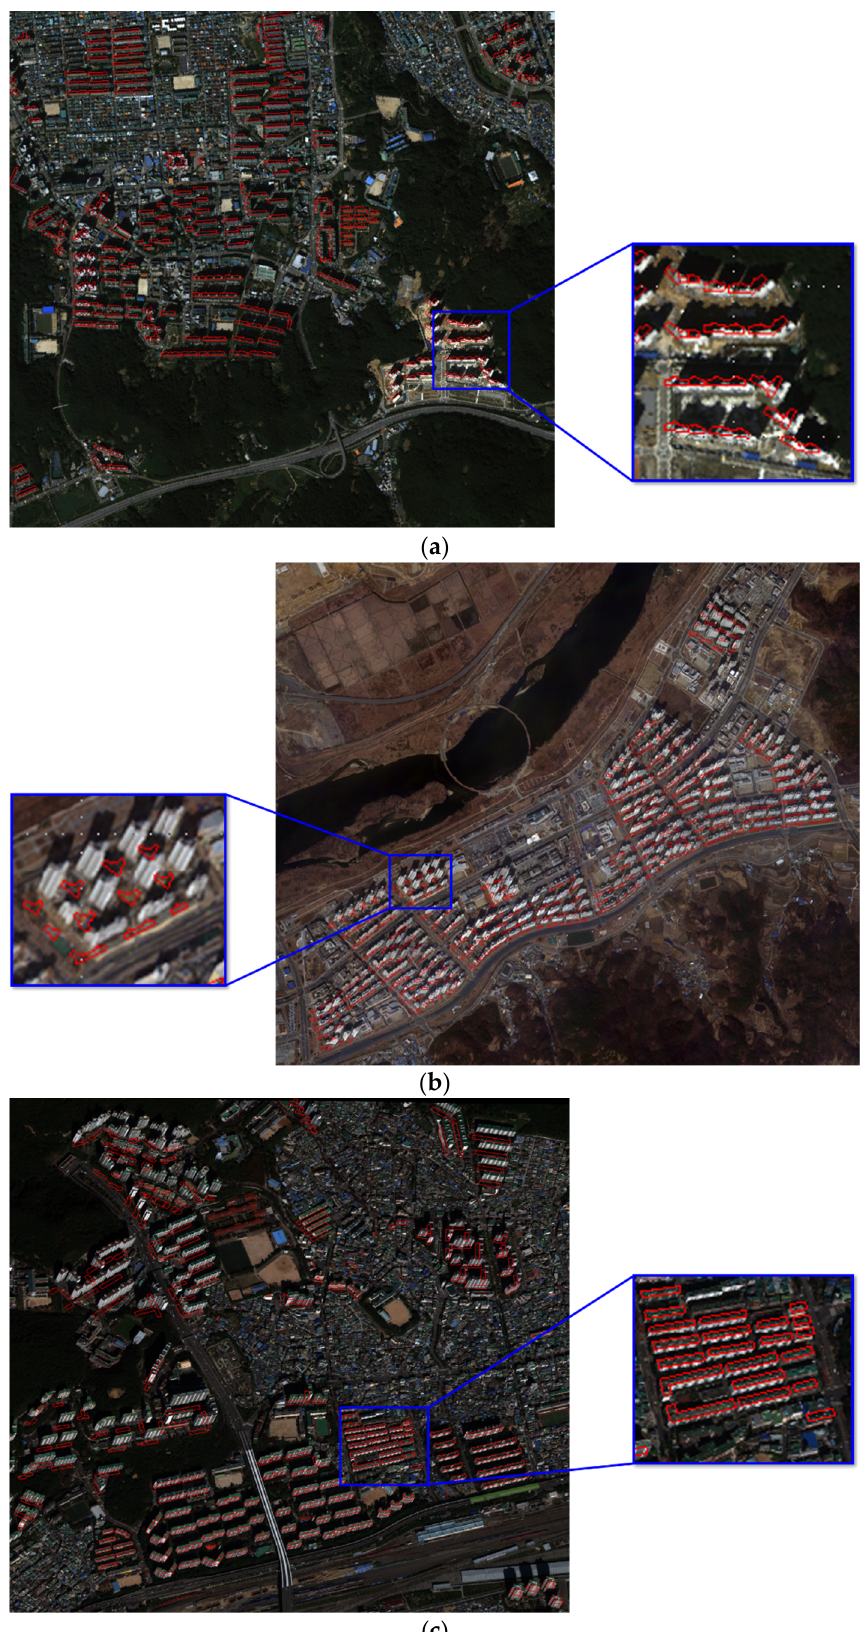
Figure 5. Satellite images and digital maps of the study areas: ( a ) KOMPSAT-3A image (Site 1); ( b ) KOMPSAT-3 image (Site 2); and ( c ) WorldView-3 image (Site 3).